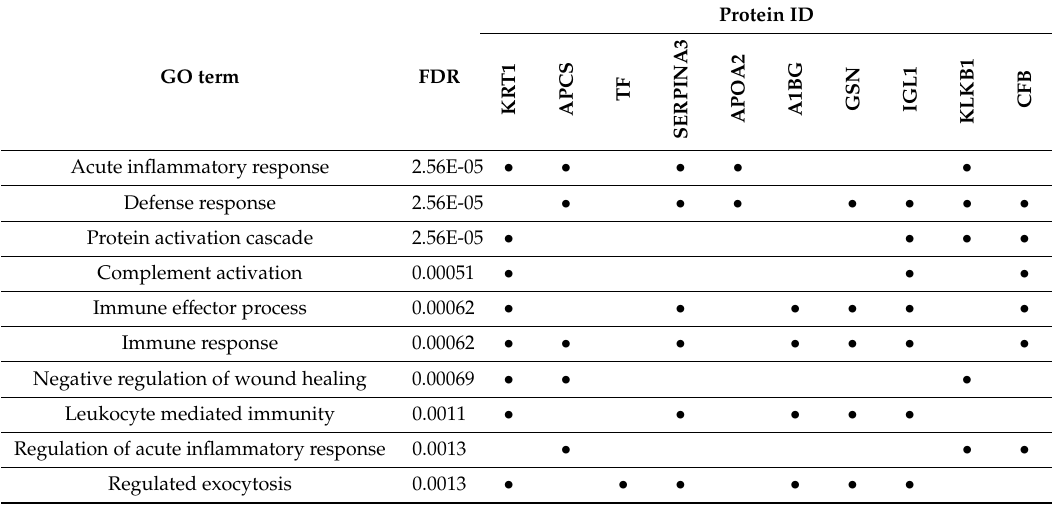
Table 6. Top 10 enriched Gene Ontology (GO) terms of down-regulated HDL -proteins due to fish oil